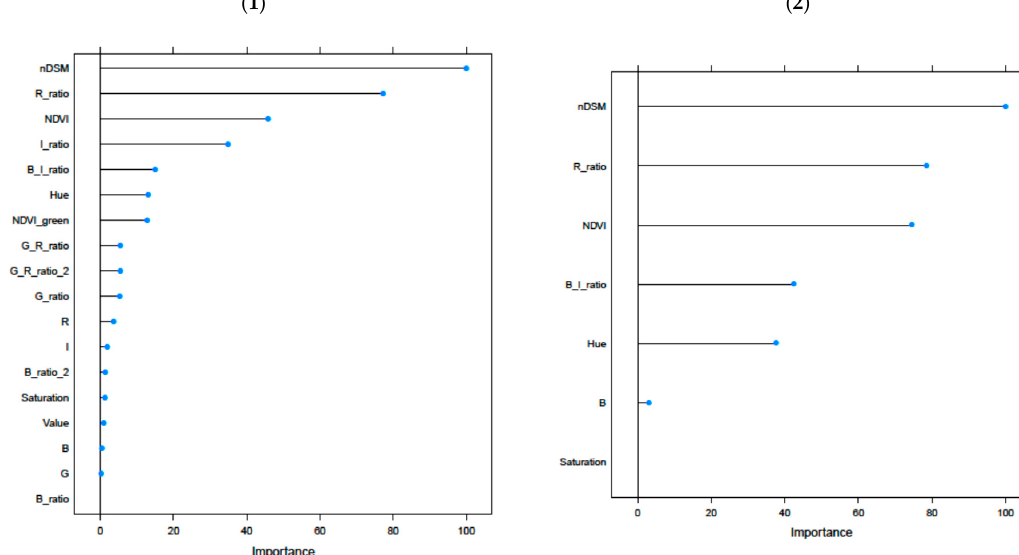
Figure A1. Variable importance in a RF model (DDLG) including all 18 predictor variables ( 1 ) and a model reduced to 7 predictor variables ( 2 ). (For variable abbreviations see Table 2). Table A1. Confusion matrix presenting the pure class validation results (confusion matrix, user’s and producer’s accuracy (in bold) and overall accuracy (in bold/italics)) of the RF model (DDLG) with (1) 18 variables versus (2) 7 variables.